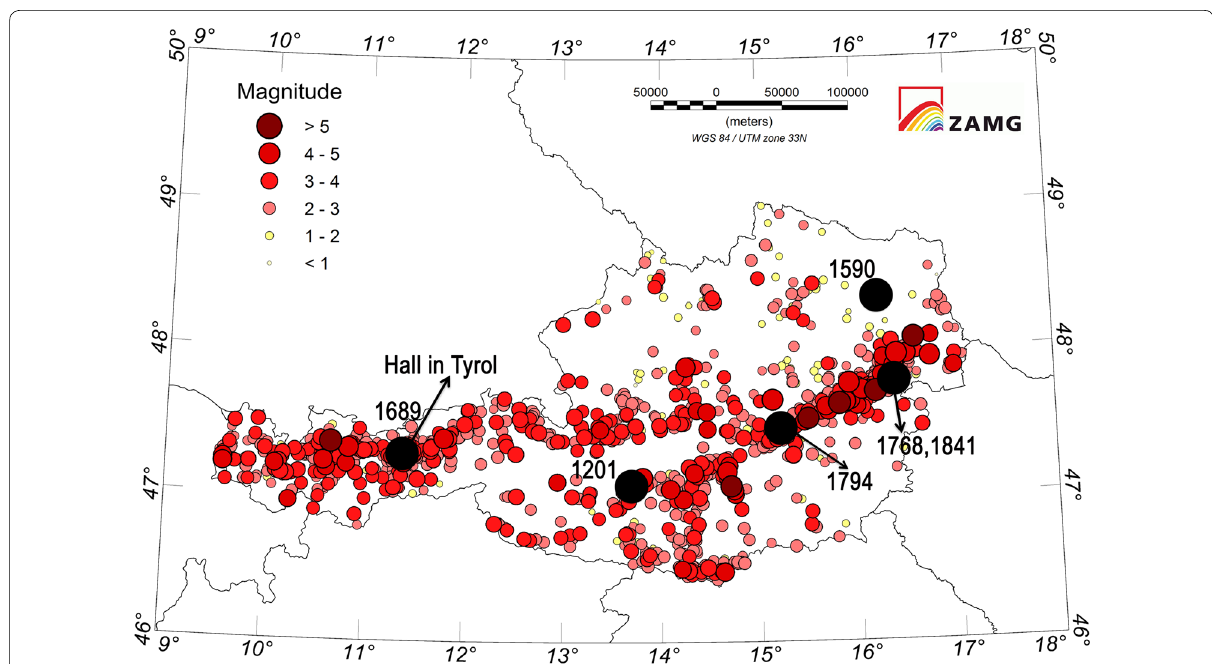
Fig. 2 Felt earthquakes in Austria since 1900. Black dots indicate the epicenters of historical earthquakes in the pre-instrumental period which are listed in Table 1 ( Source AEC (Austrian Earthquake Catalogue) June